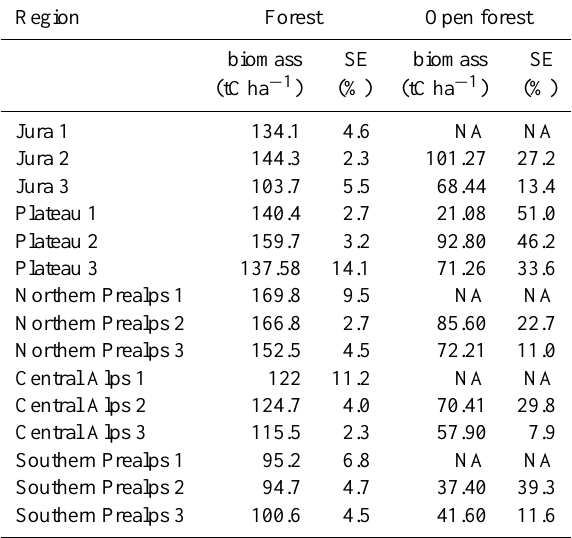
Table A2. Carbon stocks of closed forests and open forests in biomass and soils. The standard errors (SEs) refer to the deviation from the sample mean in every biogeographical region. Not included are errors of the model parameters which have been used to derive carbon stocks from tree